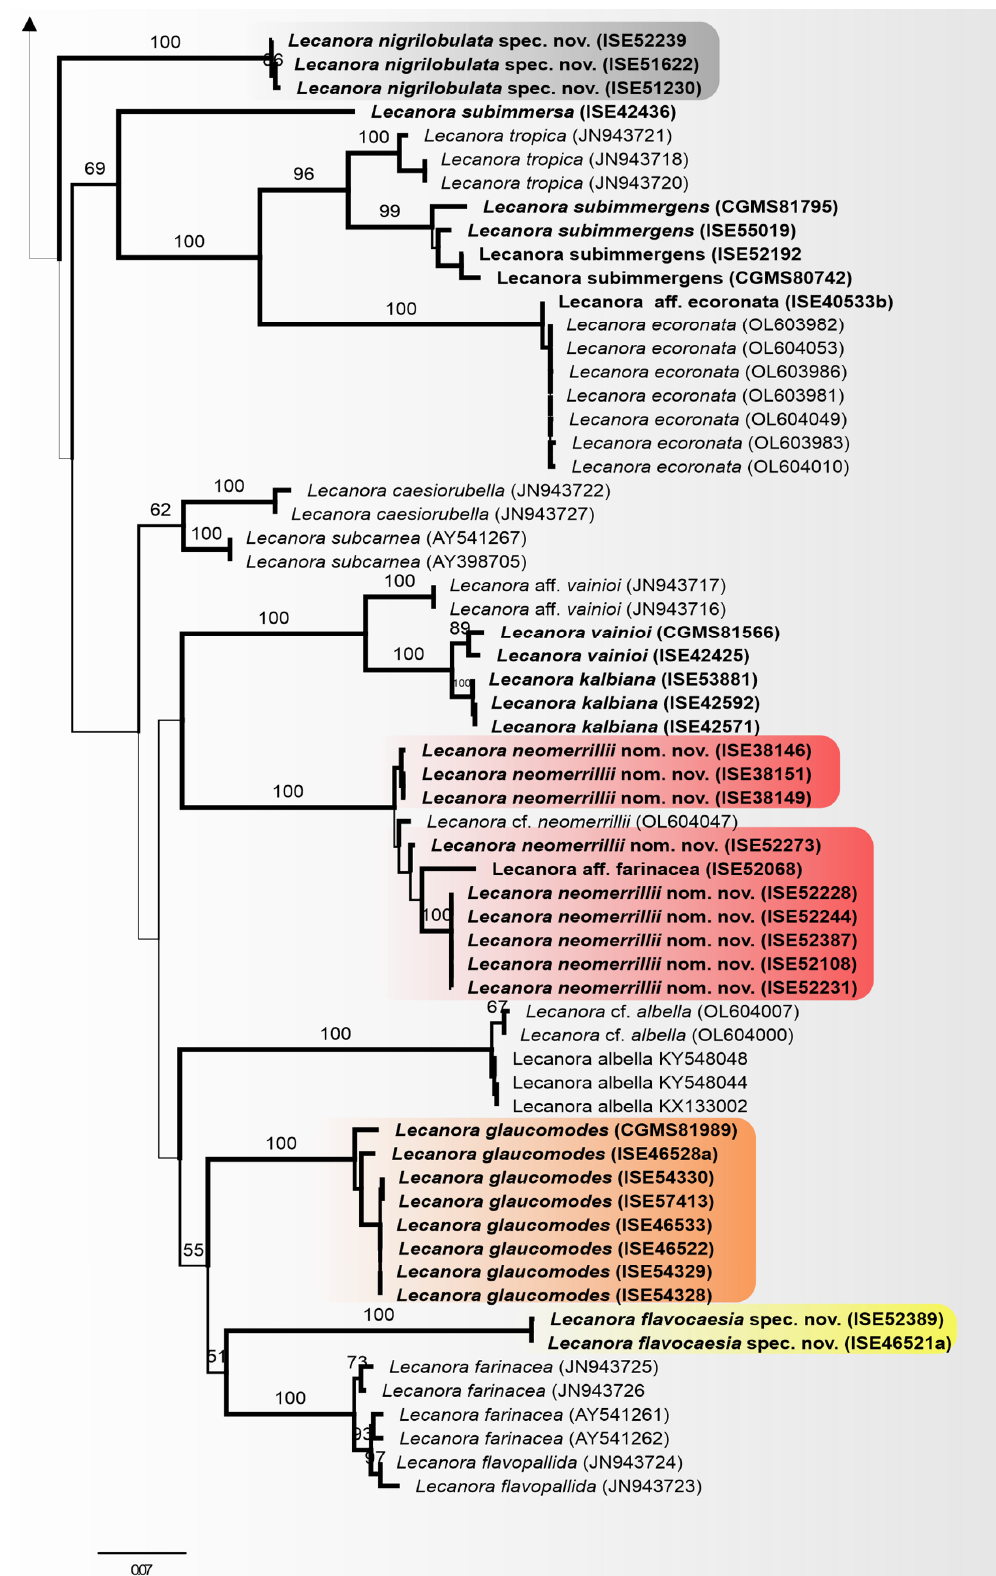
Figure 1. Best-scoring ML tree based on the analysis of ITS sequence data. Bootstrap support values are given above the branches. The new sequences generated in this study are indicated in bold and new Lecanora species is highlighted.